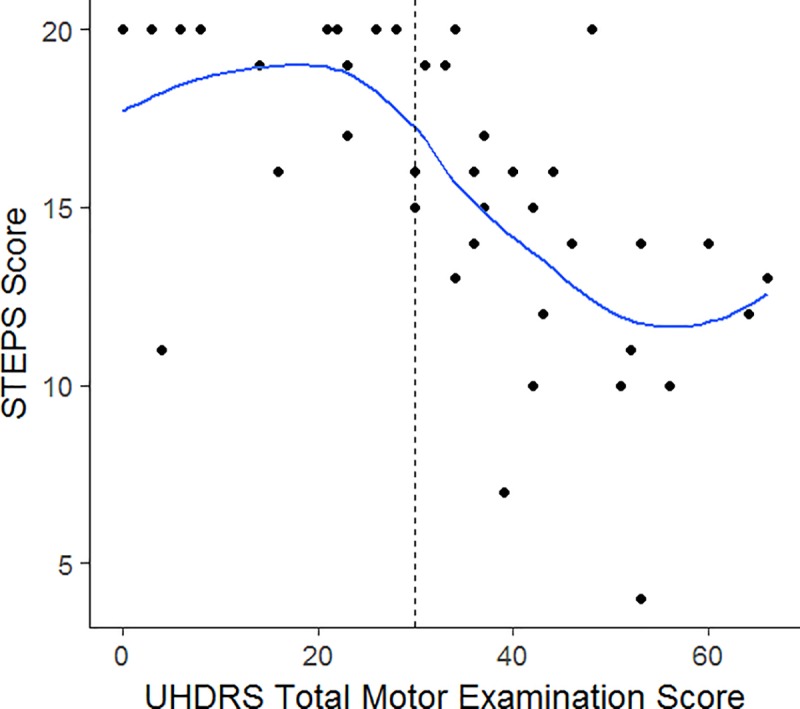
Scatterplot of total UHDRS motor examination scores versus STEPS scores with a Loess smoother.In general, performance on the STEPS was high until the UHDRS total motor score reached 30 above which declines in performance were seen.